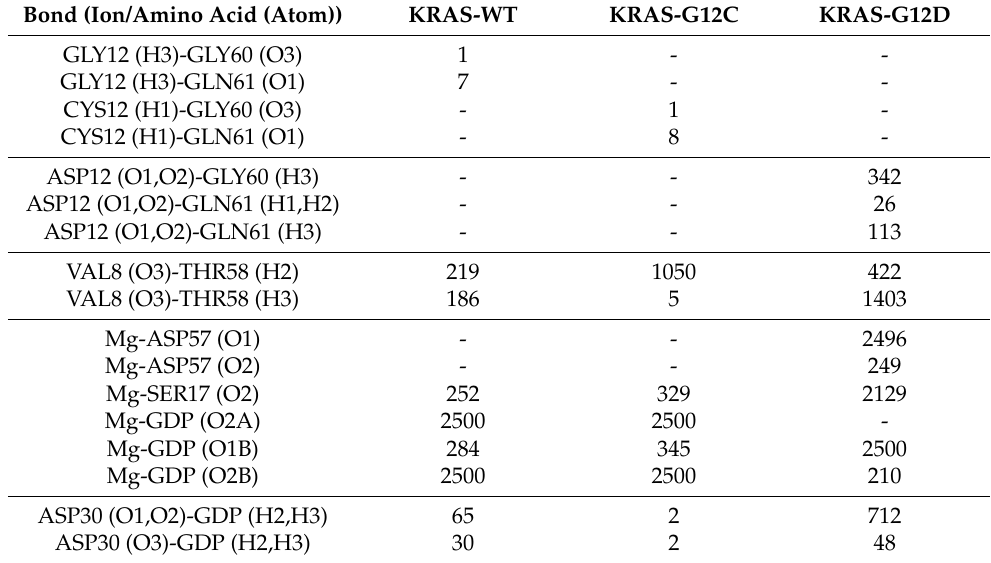
Table A2. Estimated lifetimes (in ns) of HB and CB interactions (Section 2 of main text, corresponding to Figures A4–A8). Total simulation time of 5 µ s (2.5 µ s per trajectory). We indicate in “Bond” the two amino acids or ion involved in the HB or CB and the corresponding atoms (hydrogen, oxygen) in parentheses. Double labels indicate averaged values.